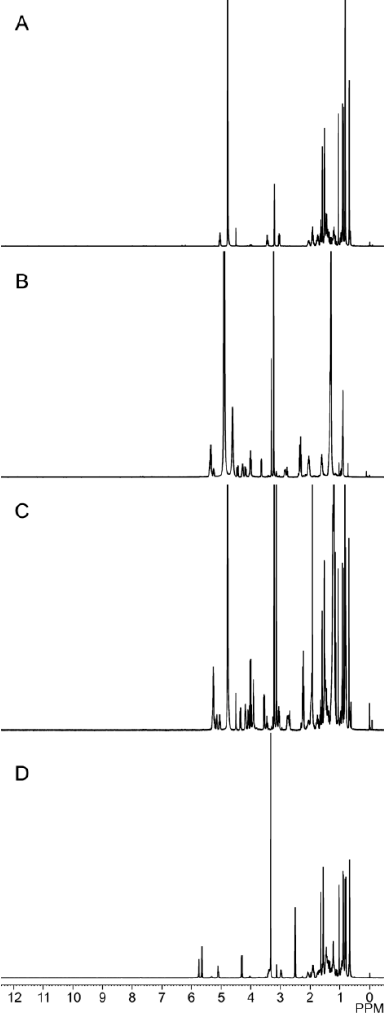
Figure 6. 1 H-NMR spectra of: ( A ) free PPD; ( B ) phospholipids; ( C ) PPD-PLC; and ( D ) physical mixture of PPD and phospholipids.